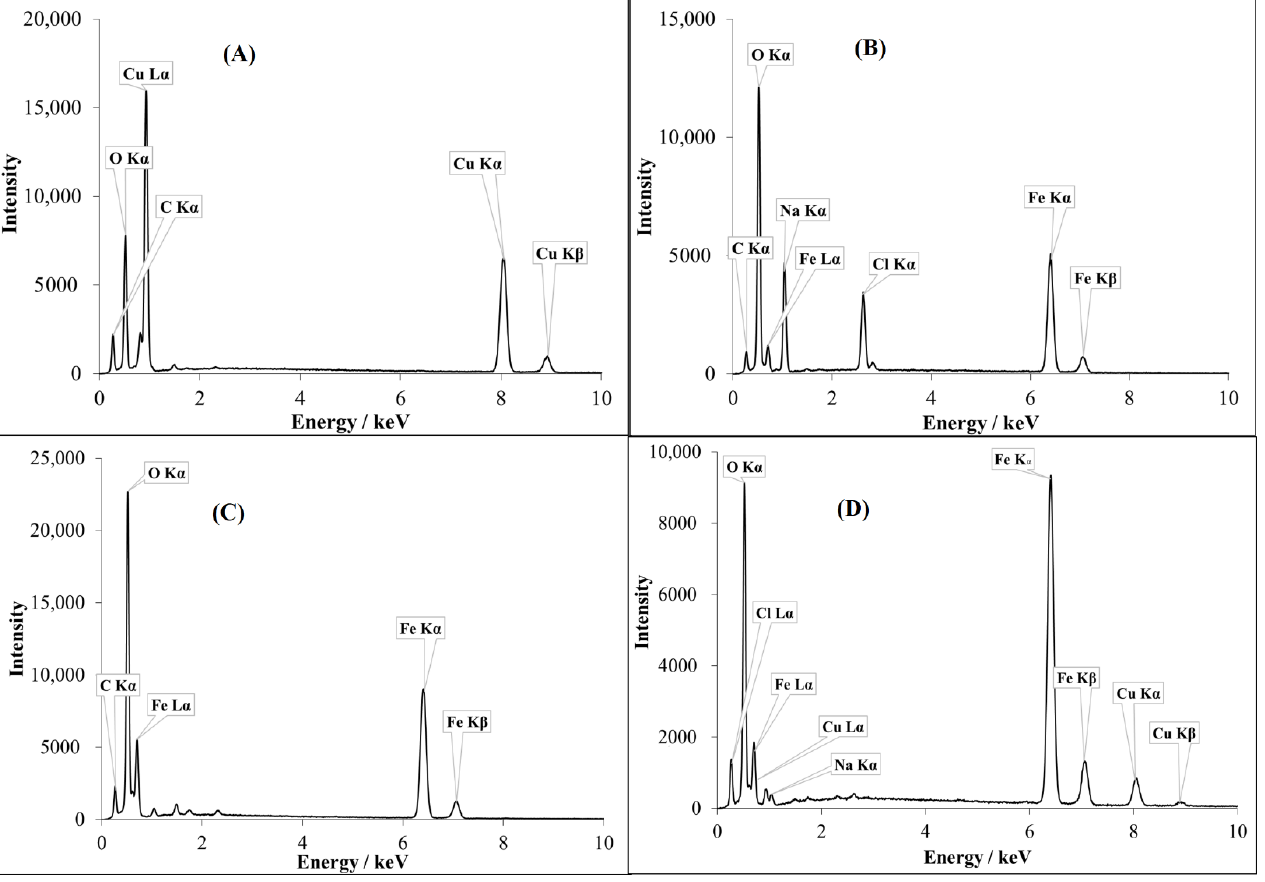
Figure 3. Energy dispersive X-ray (EDX) spectra of simple metal oxides and doped ferrite recorded in scan mode. ( A ) Cu II O ( B ) Fe III2 O 3 , ( C ) Fe II O, and ( D ) NP-3.